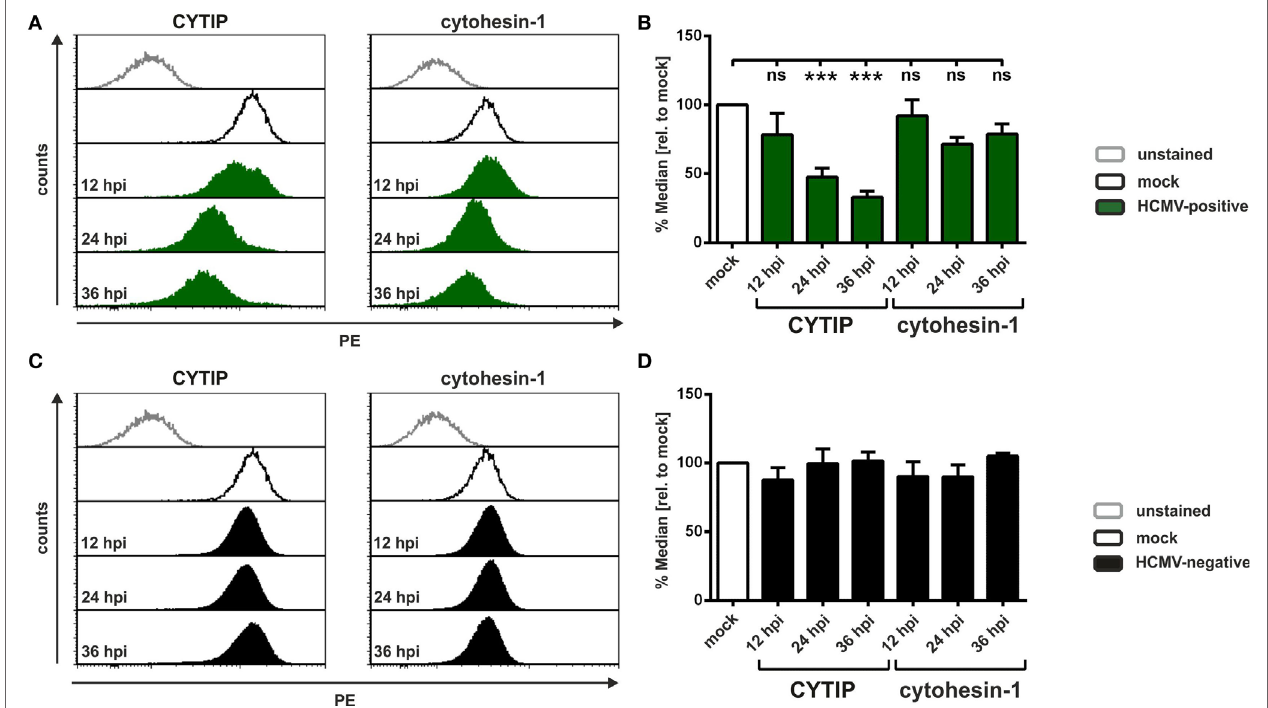
FigUre 5 | human cytomegalovirus (hcMV) induces cYTiP downmodulation early after infection . Mature dendritic cells (mDCs) were mock- or HCMV-infected and harvested at the indicated time points post-infection. Cells were intracellularly stained with antibodies specific for CYTIP or cytohesin-1 and subjected to flow cytometric analyses. (a,c) Representative data of one donor are shown for CYTIP (left panel) or cytohesin-1 (right panel) expression levels 24 hpi. Mock conditions are depicted as black lines (exemplary for 24 hpi), (a) HCMV-positive cells as filled green histograms and (c) HCMV-negative cells as filled black histograms. (B,D) Quantification of CYTIP and cytohesin-1 protein levels 12 hpi ( n = 3), 24 hpi ( n = 6) and 36 hpi ( n = 3). Median values of (B) HCMV-positive (green bars) and (D) HCMV-negative (black bars) mDCs were calculated relative to the respective mock condition (white bars). Significant changes (*** = p < 0.001) are marked by asterisks, non-significant changes ( p > 0.05) as